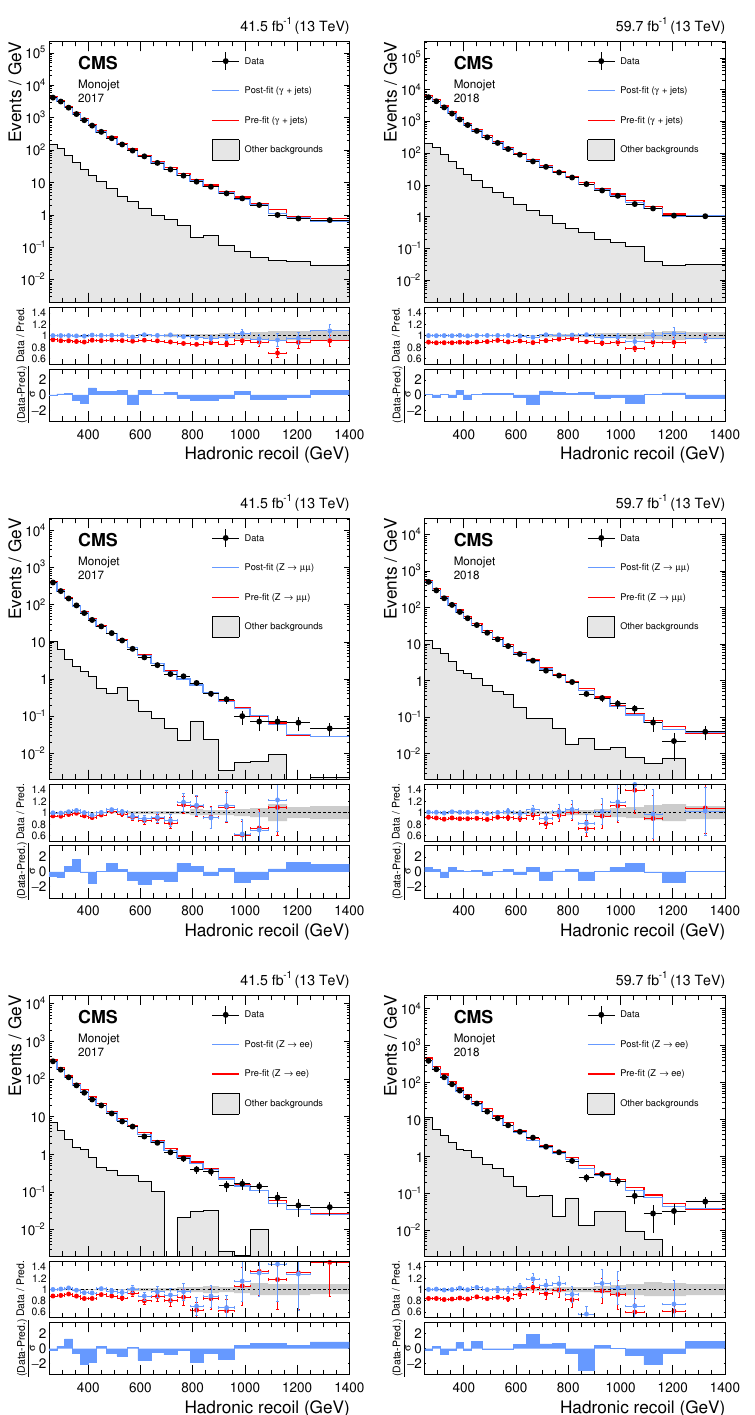
Figure 13 . Hadronic recoil distributions in the photon (upper), dimuon (middle) and dielectron control regions (lower) in the monojet category. The “Other backgrounds” include QCD multijet production (photon control region), and top quark, diboson, and W + jets processes (dimuon and dielectron control